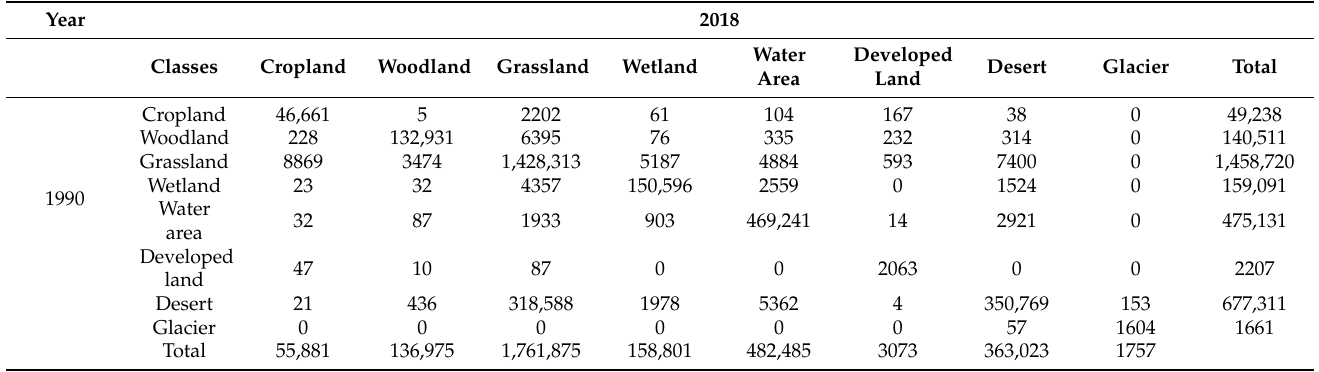
Figure 5. The proportion of landscape types in the QLB from 1990 to 2018. Table 6. Transition matrix of landscape types in the QLB from 1990 to 2018 ( × 10 4 m 2